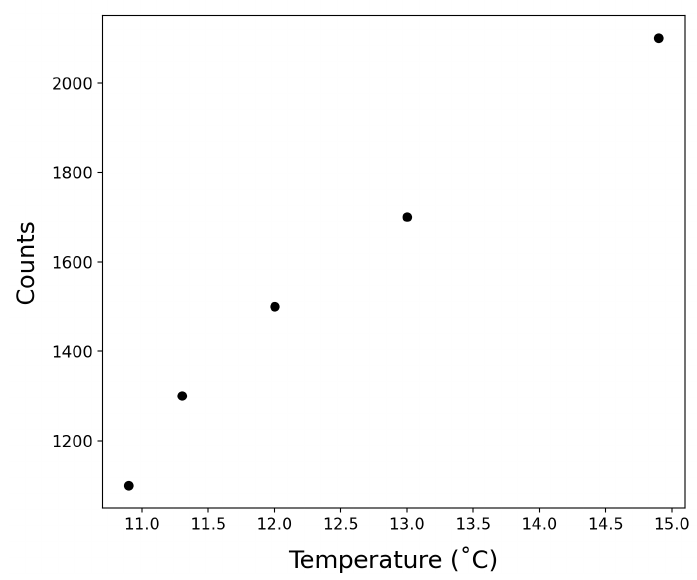
Figure 7. The raw photon counts observed by the PMT from MCLA at different